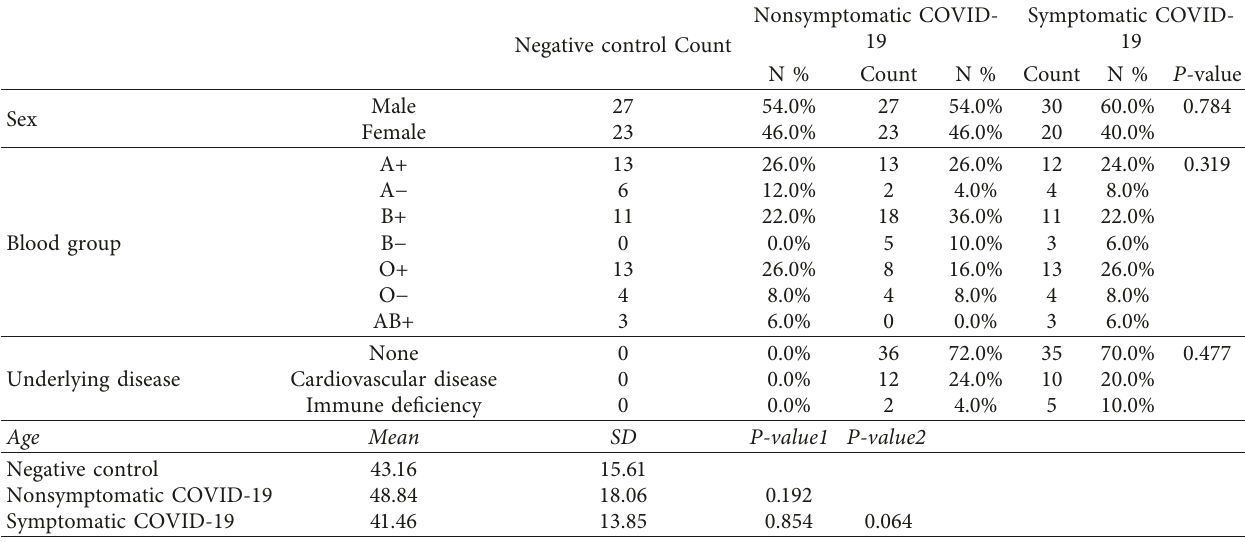
Table 2: Baseline and demographic characteristics of participants ( P values 1: in comparison with negative control, 2: in comparison with nonsymptomatic